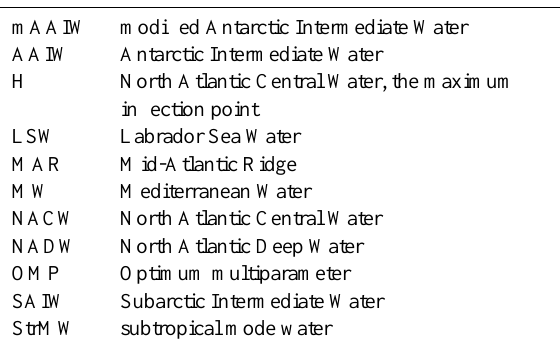
Table 1. List of the main acronyms.